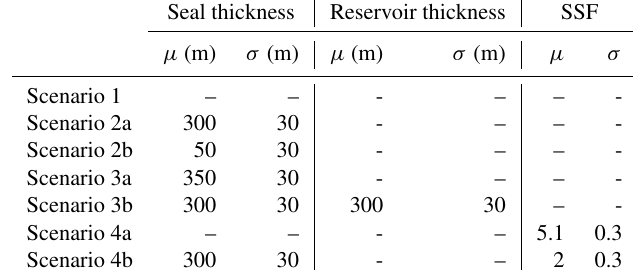
Table 2. Normal distribution mean ( µ ) and standard deviations ( σ ) for the likelihoods implemented in the different scenarios.